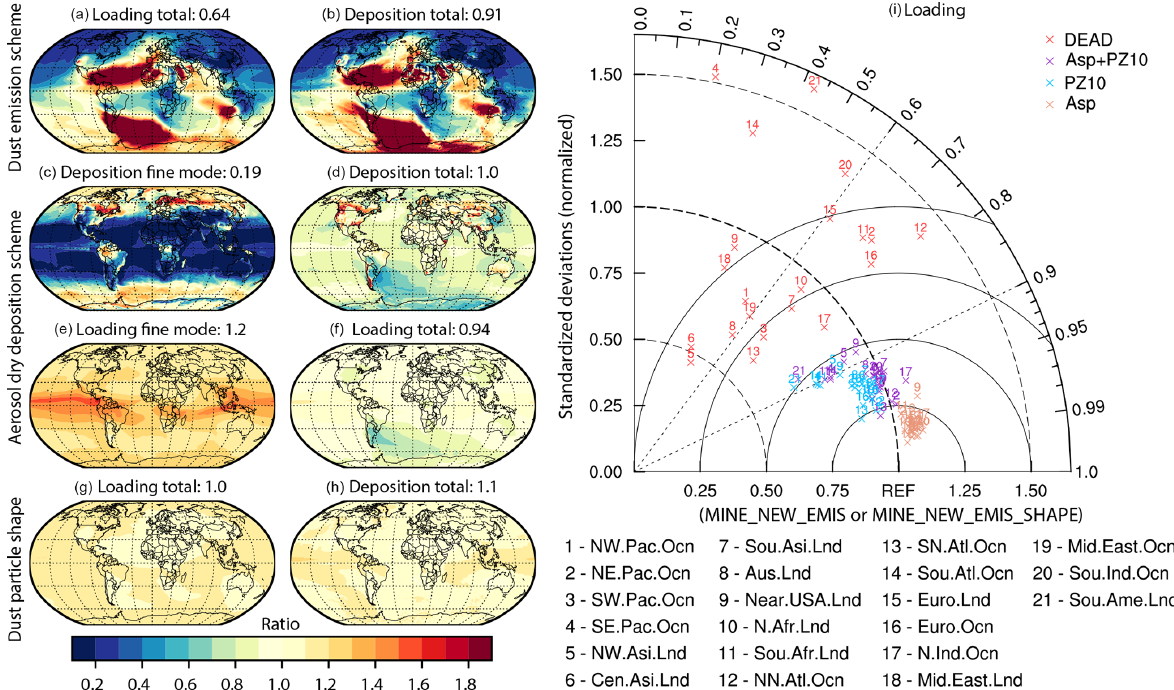
Figure 7. Impacts of the dust emission scheme ( a and b : ratio of BRIFT to DEAD), aerosol dry deposition scheme ( c–f : ratio of PZ10 to Z01), and dust shape ( g and h : ratio of ellipsoidal to spherical dust) on the modeled dust deposition (total: b , d , and h ; fine mode: c ), and dust loading (total: a , f , and g ; fine mode: e ). The Taylor diagram (i) compares dust loading in 21 sub-regions defined in Fig. S16. In panels (i) , DEAD shows comparison between MINE_BASE and MINE_NEW_EMIS; Asp + PZ10 between CAM6. α _MINE and MINE_NEW_EMIS; PZ10 between CAM6. α _MINE and MINE_NEW_EMIS_SHAPE; the Kendall’s τ temporal correlation and the standard deviation were obtained based on monthly values with the seasonal cycle